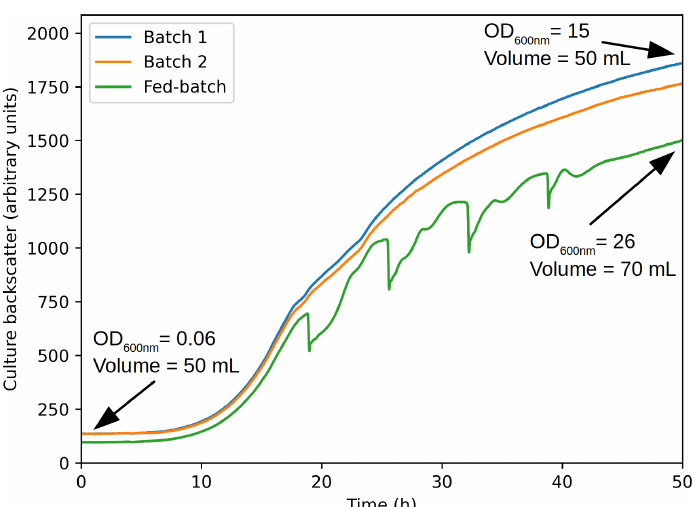
Figure 7. Backscatter signals from batch and fed-batch cultures conducted on the medium ensuring the highest